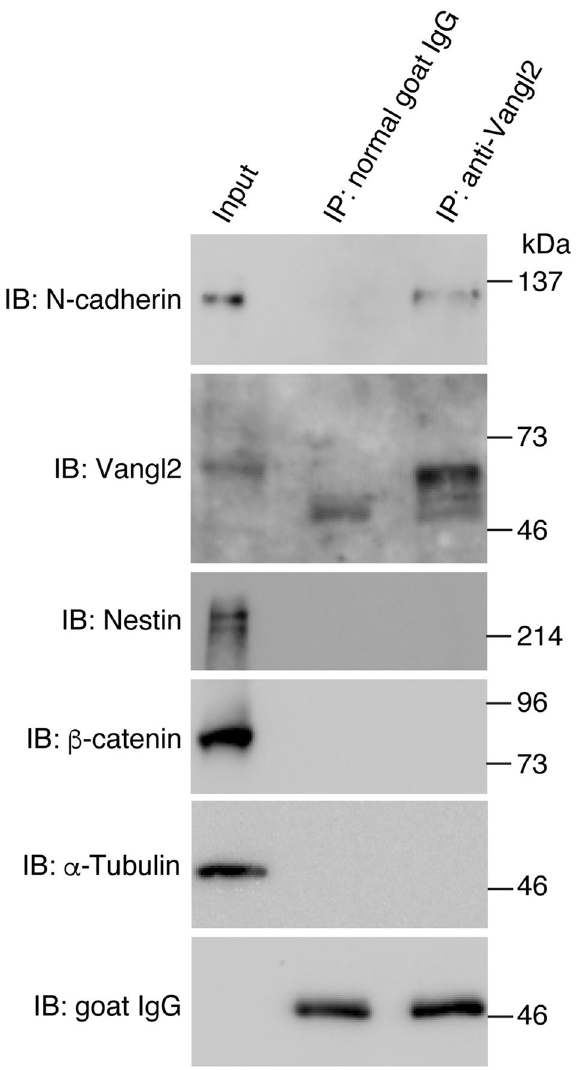
Figure 1. N-cadherin—Vangl2 association in neural tube cells. Immunoprecipitation using normal goat IgG or goat anti-Vangl2 antibodies from neural tube cell lysates derived from E9.5 embryos. Western blot analysis of the input (1.7%) and IP (~ 50%) using the indicated antibodies confirmed the specific co-immunoprecipitation of N-cadherin by anti-Vangl2